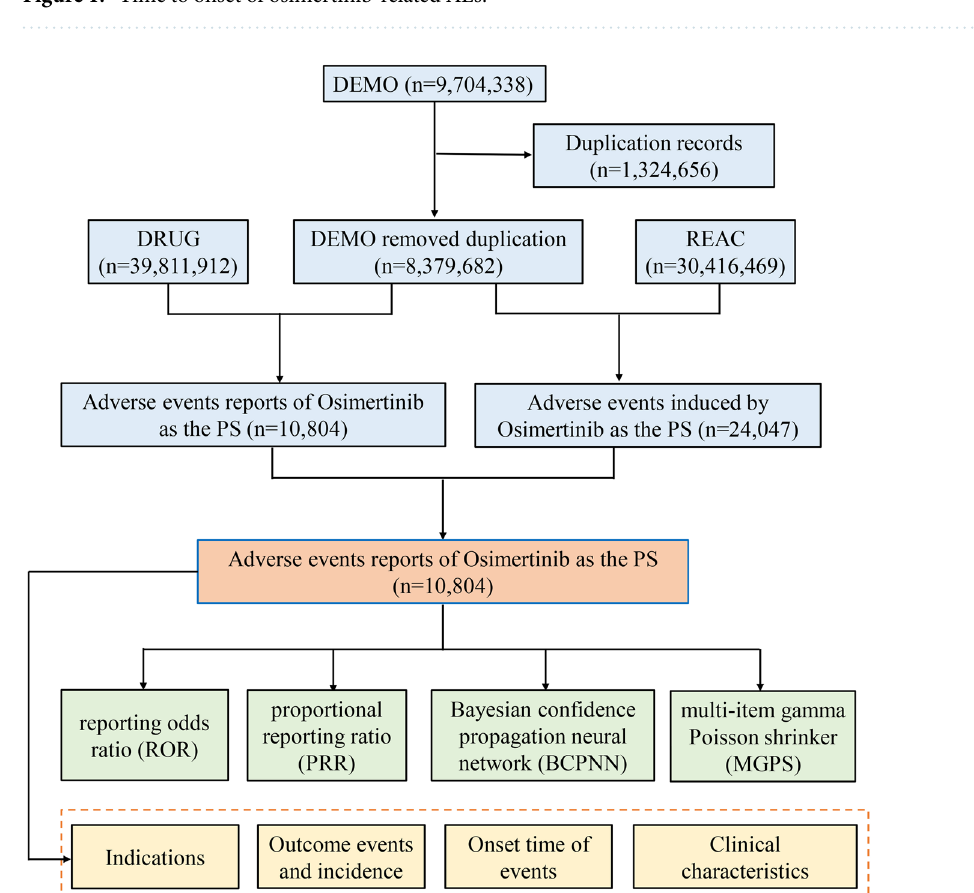
Figure 2. Flow diagram of this study ( DEMO demographic and administrative information, DRUG drug information, REAC preferred terminology for adverse event, PS primary suspect